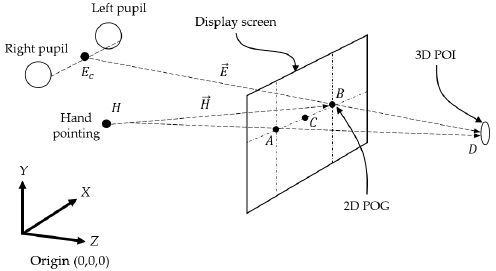
Figure 1. Three-dimensional point-of-intention (3D POI) determined through the eye gaze and hand